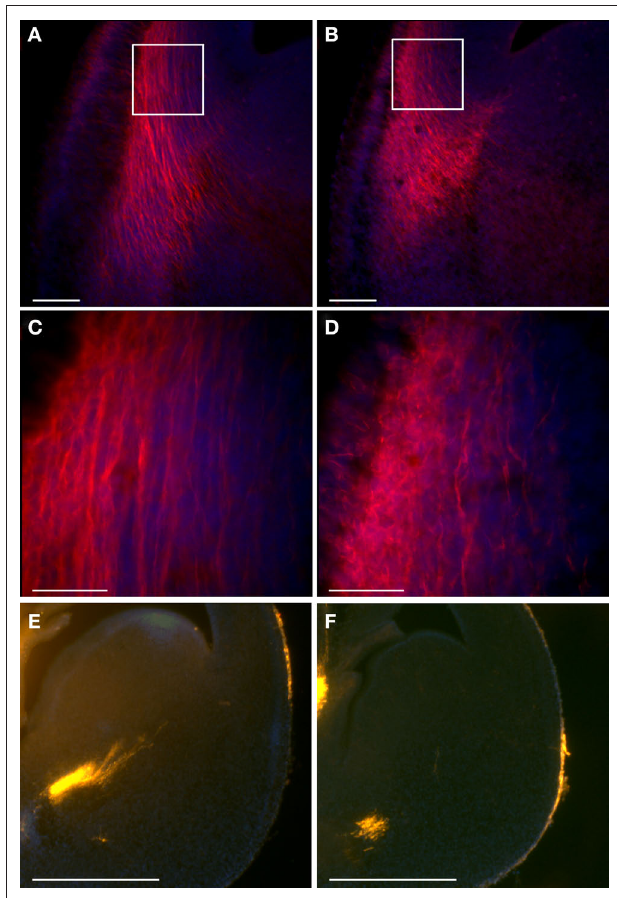
FIgure 7 | Double KO mice exhibit earlier thalamocortical projections. (A–D) TAG-1 immunostaining of double KO (A,C) and control (B,D) mice. Scale bars: ( A,B) – 100; ( C,D) – 40 μm. The white boxes in (A) and (B) define the area shown in (C) and (D) . (e,F) DiI stained thalamocortical fibers exhibit earlier projections in double KO brains (e) in comparison to the control brains (F) . Scale bars are 500